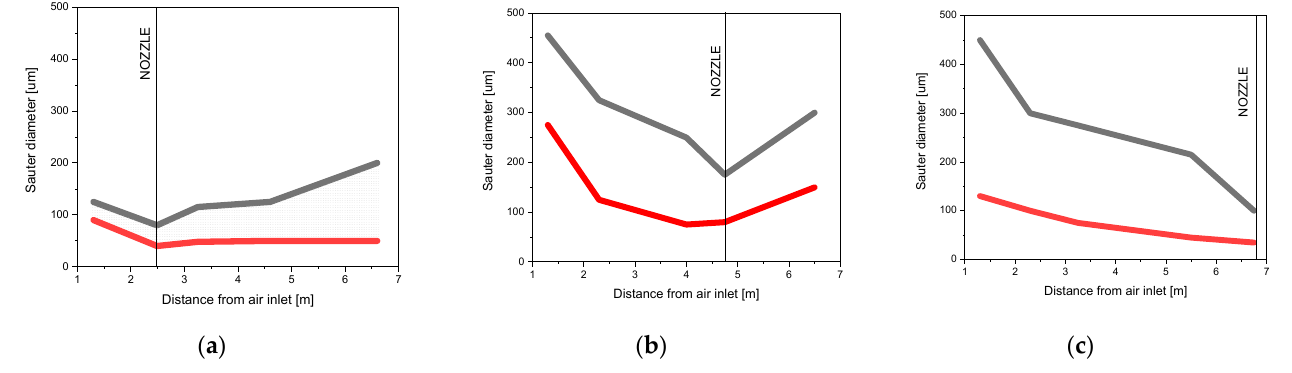
Figure 3. Area of changes of an average particle diameter along the drying tower for different nozzle positions ( a – c ), slurry and airflow rate, swirl flow, atomization ratio, and air temperatures. Results of the experiments proved that the position of the nozzle in relation to the hot air inlet had a significant influence on the agglomeration process. Phenomena decisive for the course of agglomeration take place in the atomization zone, i.e., the area from the nozzle to about 1.5 m below the nozzle. By changing the location of the nozzle, the temperature and air velocity profiles—which are in direct contact with the sprayed particles—are